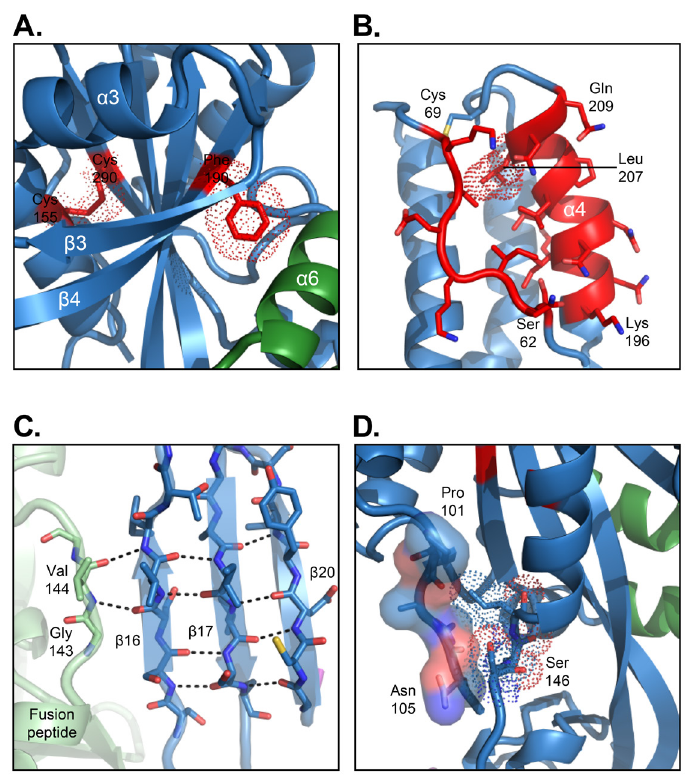
Figure 2. Atomic-level details of the RSV B18537 F glycoprotein structure . (A) Prefusion stabilizing DS-Cav1 mutations (S155C, S190F, S290C) are shown with van der Waals surface (red dots) with the adja- cent secondary structure including the domain III β-propeller fold shown in ribbon format. (B) Antigenic site Ø located at the apex of each protomer is highlighted in red with side chains in stick representation. The V207L mutation, which is part of the stabilizing mutations, is highlighted in dot representation. (C) Inter-protomer hydrogen bonds between the fusion peptide of one protomer and β strands 16, 17, and 20 from an adjacent protomer are indicated by dotted lines. (D) Interaction between the F2 C-terminus and the fusion peptide within a single protomer. The F2 C-terminus is shown in surface representation and the fusion peptide shown with dotted van der Waals